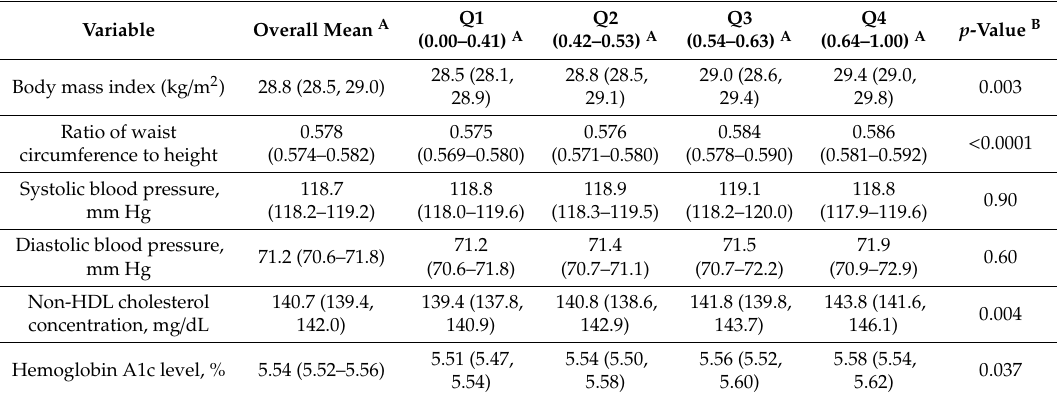
Table 2. Cardiometabolic risk factors by subsidy score quartiles, taken from the National Health and Nutrition Examination Survey from